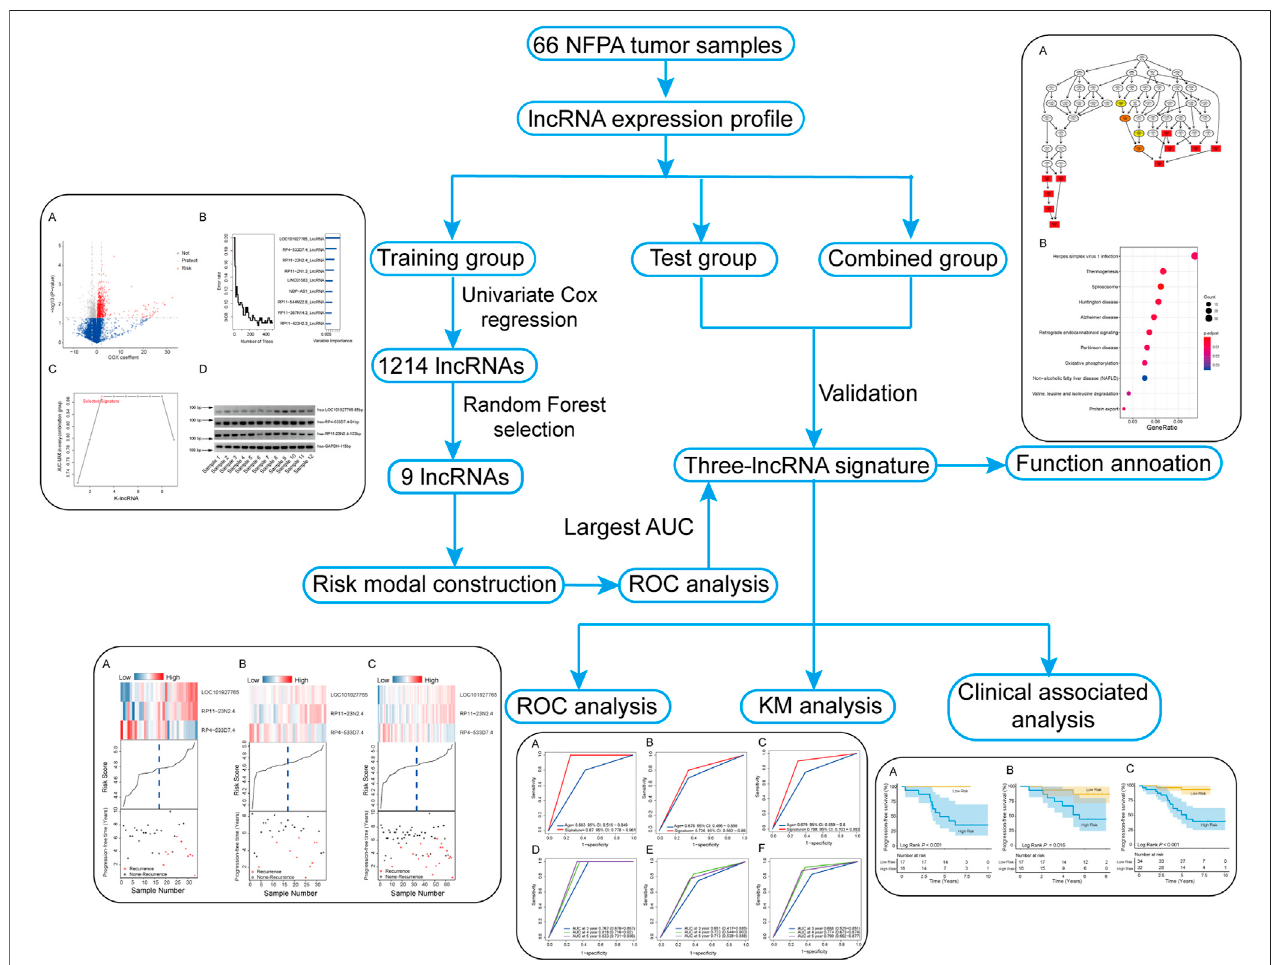
FIGURE 1 | Flowchart of the